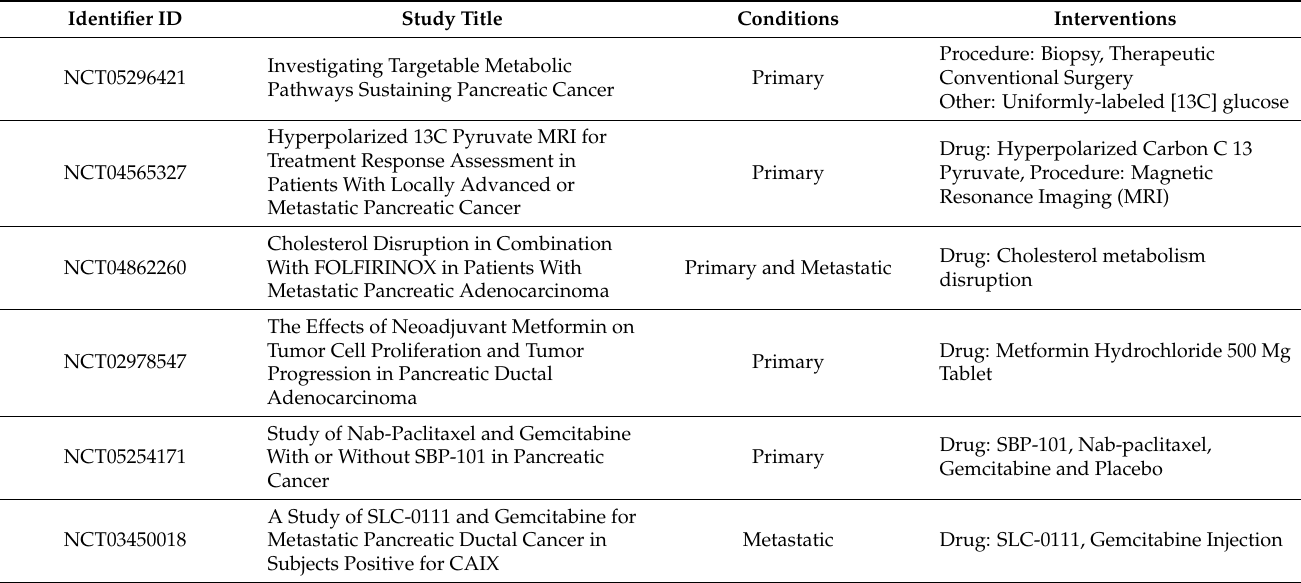
Table 1. List of clinical trials for PDAC’s metabolic investigation (source https://clinicaltrials.gov/ accessed on 29 June 2022; Condition or disease: PDAC Pancreatic Ductal AdenoCaricnoma and other terms: